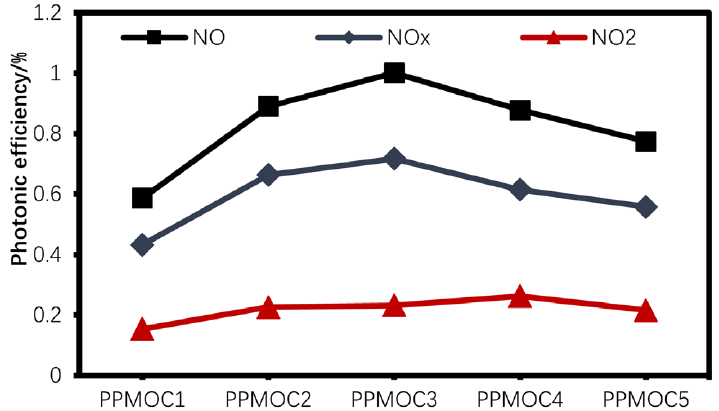
Figure 6. Photonic efficiency (ξ) of NO and NO x removal and intermediate product NO 2 formation of loading PPMOC twice. The PPMOC number in x axis means different porosity (shown in the experimental section).